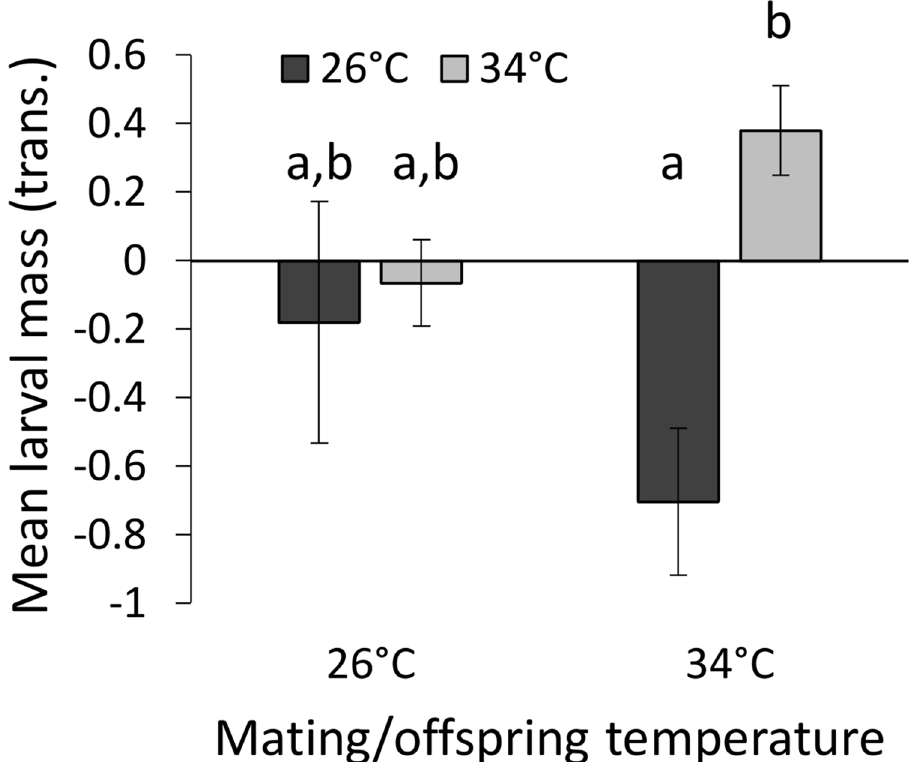
Fig 4. The interaction between mating/offspring temperature (X axis) and adult temperature in their effect on mean larval mass (left/dark grey columns and right/bright grey columns represent the colder and warmer adult temperatures (26°C and 34°C), respectively. Mean larval mass is positively affected by the mating/offspring temperature, but only when adults experience the warmer temperature. Means ± 1 SE are presented. Letters indicate statistical differences among groups based on a Tukey's post-hoc test.